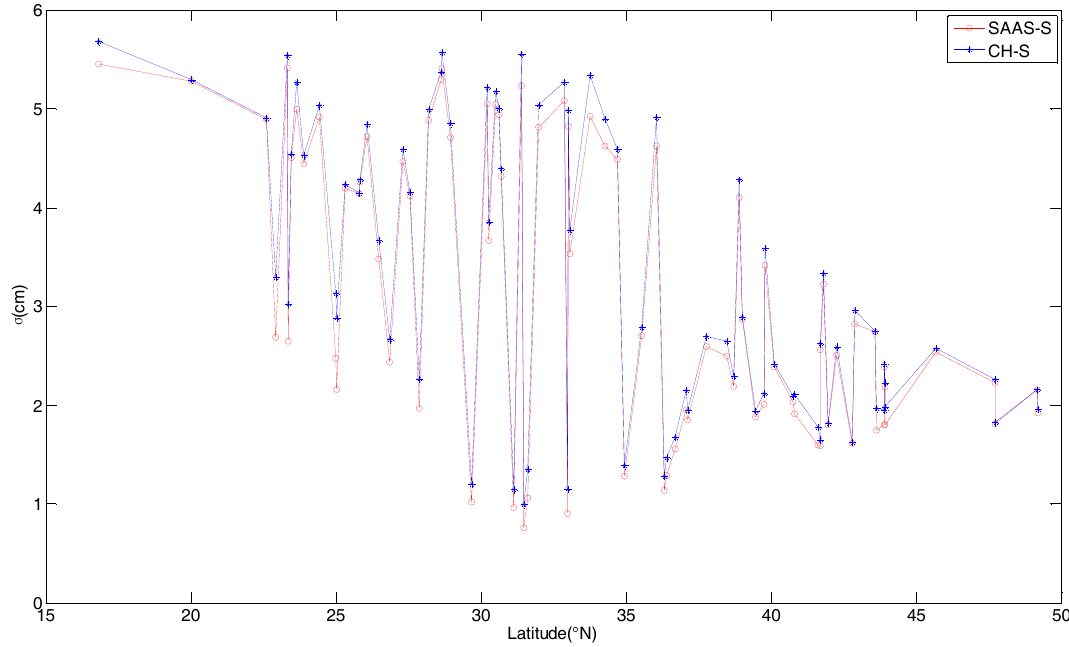
Figure 2. The variations of σ for the two single-site models in different regions.